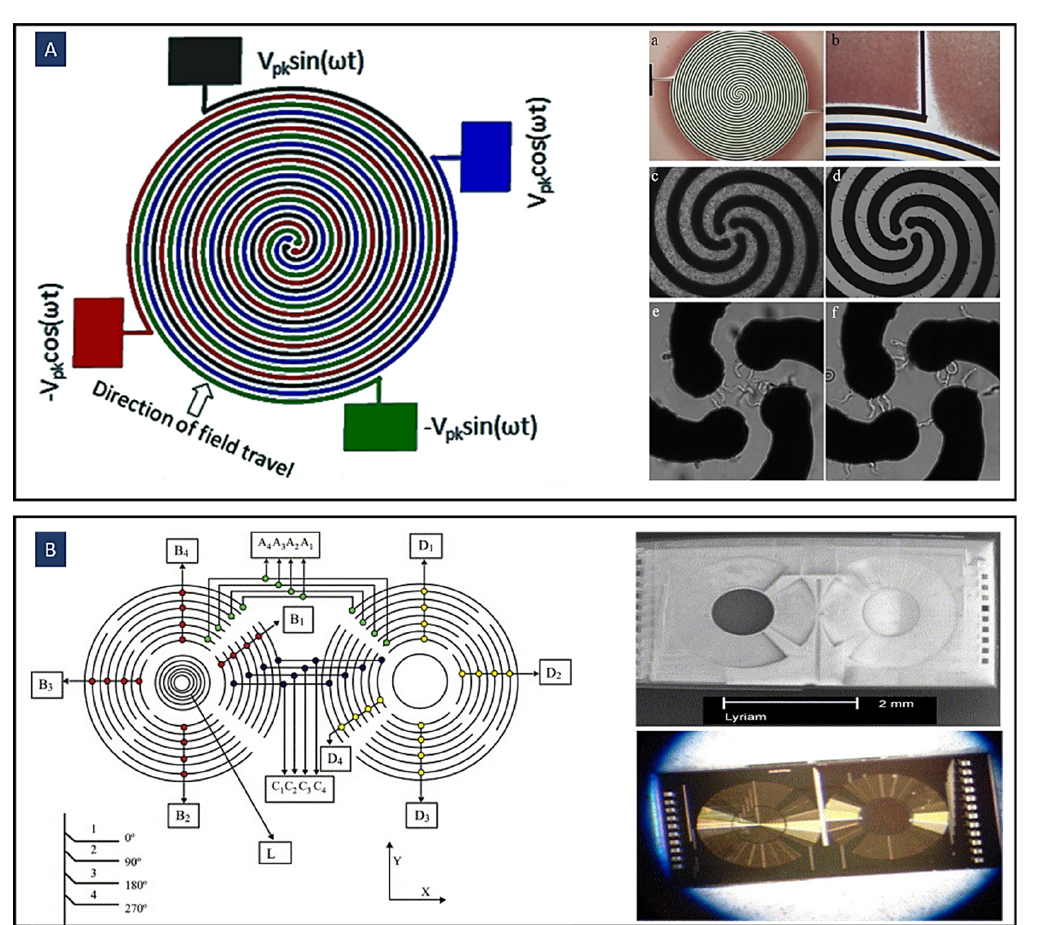
Figure 7. ( A ) Trypanosome Enrichment and Detection in Blood using Counterflow Dielectrophoresis and spiral electrodes (Reprinted with permission from [70]. Copyright 2012, Springer Nature); ( B ) the combination of DEP, twDEP, and Electrorotation microchip to characterize and manipulate human malignant cells (Reprinted with permission from [106]. Copyright 2004,